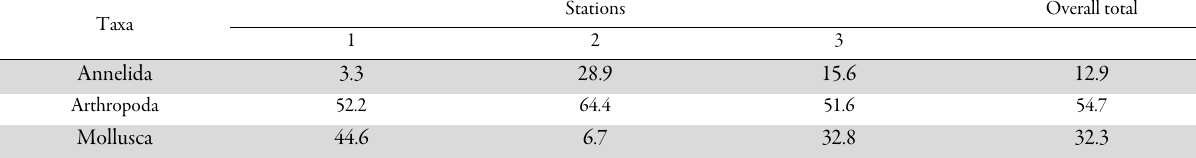
Table 3. Percentage contribution of major macroinvertebrate groups in the study stations